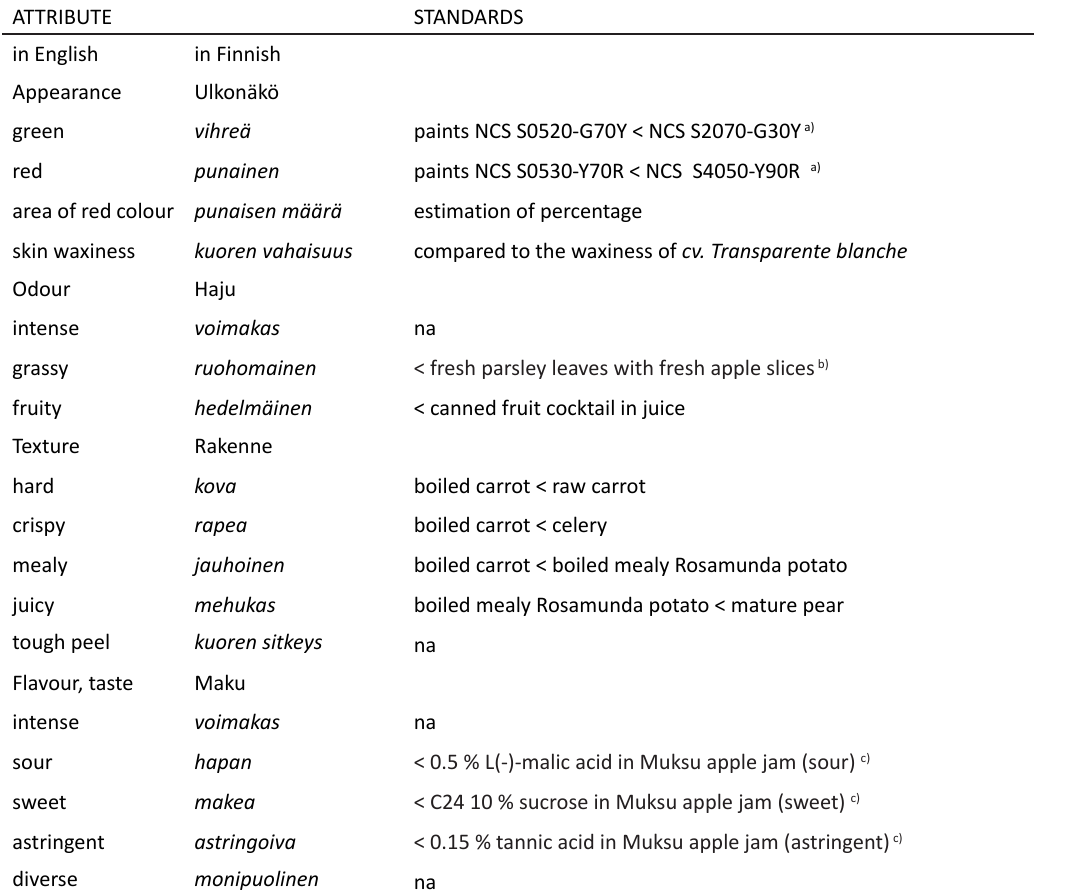
Table 4. The attributes and references used in descriptive analysis in 2009–2011 (Seppä et al. 2012, Seppä et al. 2013a)